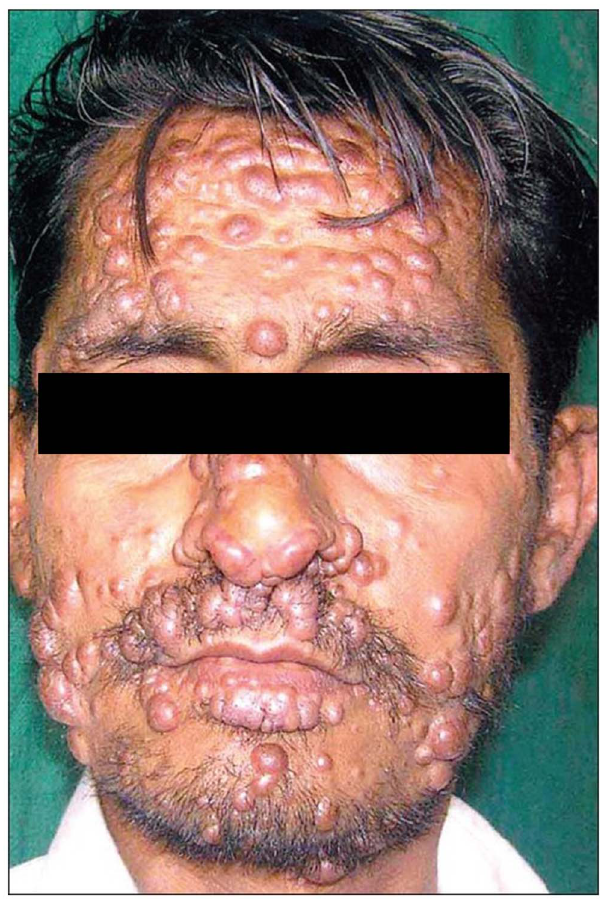
Figure 4. Diffuse or disseminated cutaneous leishmaniasis in an HIV-positive patient from Rajasthan, India (endemic for CL, not VL). There are florid nodules mainly on the face and on the extremities and back; oral and nasopharyngeal infiltrations were also found. There was no previous ulcer nor were there signs of visceralization. The parasite was not typed. Reproduced with permission from Chaudhary et al., the Indian Journal for Dermatology, Venereology and Leprology